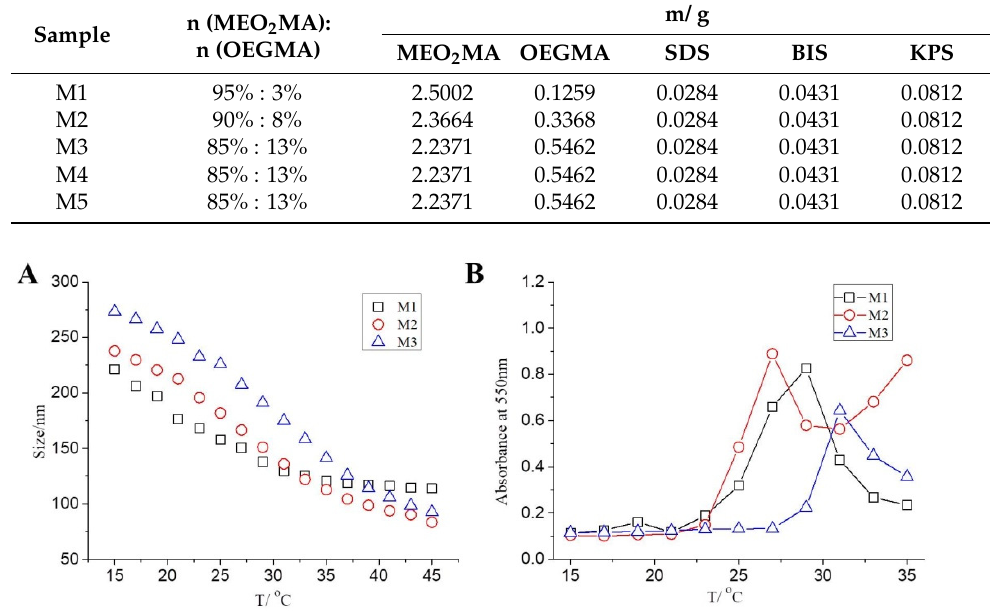
Table 1. The feeding amount of each sample during the preparation process.